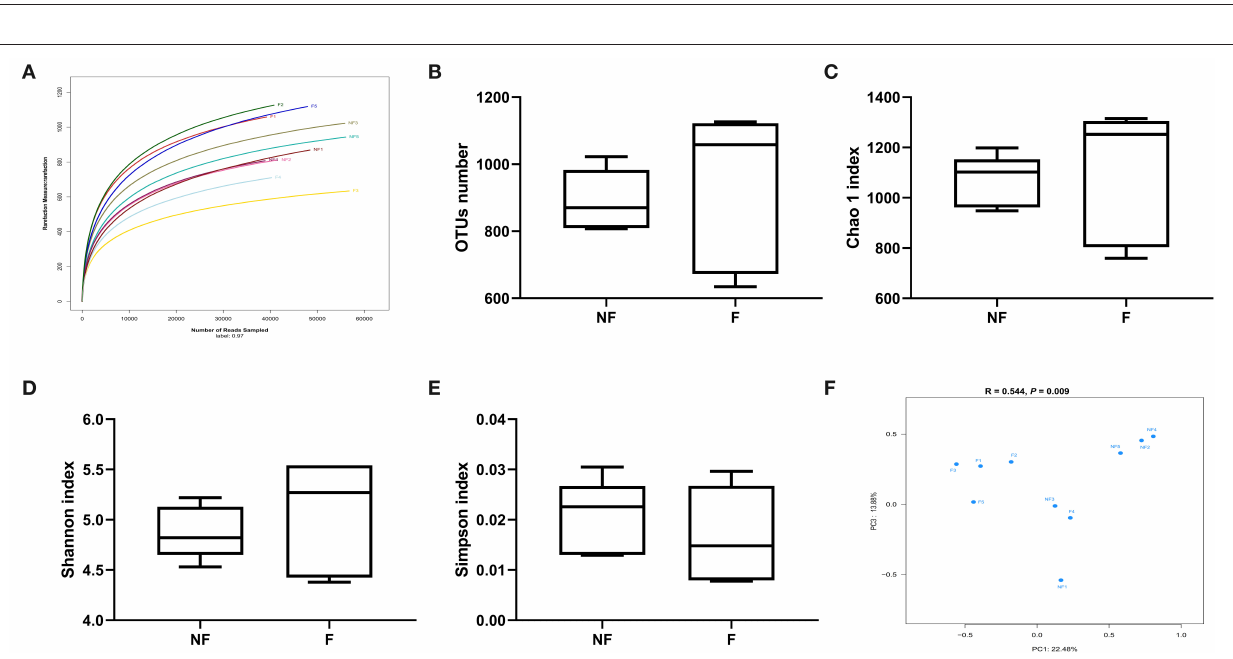
FIGURE 7 | Effects of fiber supplementation in gestation diet on bacteria community diversity and richness between the two groups. (A) Rarefaction curve; (B) Number of operational taxonomic units (OTUs); (C) Chao 1 index; (D) Shannon index; (E) Simpson index; (F) The principal coordinate analysis (PCoA) profile of the two groups displayed with Bray_curtis distance, and analysis of similarities (ANOSIM) was used to evaluate differences among the microbial communities. NF, sows fed with a semi-purified basal diet (0.01% dietary fiber); F, sows fed with a semi-purified basal diet supplemented with 8.33 g/kg inulin and 200 g/kg cellulose. NF 1, 2, 3, 4, and 5 means colonic digesta samples from sows fed NF diet; F 1, 2, 3, 4, and 5 means colonic digesta samples from sows fed F diet. n = 5 per group. Significant differences are displayed in the figures by * P <